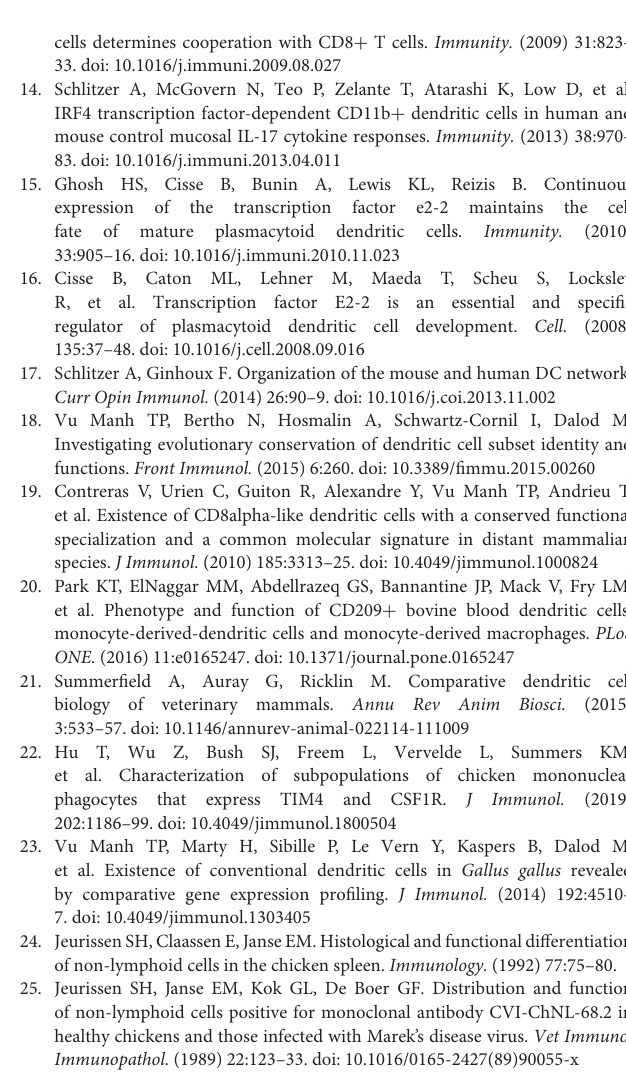
Supplementary Figure 6 | Analysis of the location of fluorescent bead particles 3h post-IV administration in chicken spleen. Supplementary Figure 7 | Flow cytometric analysis of adherent primary chicken splenocytes cultured for 48h and in vitro phagocytosis controls at 4 ◦ C and Cytochalasin D treatment. Supplementary Figure 8 | RNA-seq analysis of the chicken splenic subpopulations indicate enrichment for core T cell, NK cell, and B cell in the CSF1R -tg neg subpopulations. Supplementary Figure 9 | RNA-seq analysis of the chicken CSF1R -tg + subpopulations indicate enrichment of migratory and adhesion related genes in the CSF1R -tg hi MHCII hi CD11c dim subpopulations. Supplementary Figure 10 | The CSF1R -tg dim subpopulations are depleted 3 days post-clondronate liposome treatment. Supplementary Table 1 | Differentially expressed genes comparison in splenic CSF1R -tg neg and CSF1R -tg + subpopulations (FDR < 0.5). Supplementary Table 2 | Differentially expressed chicken heterophil related genes comparison in splenic CSF1R -tg + subpopulations (FDR <